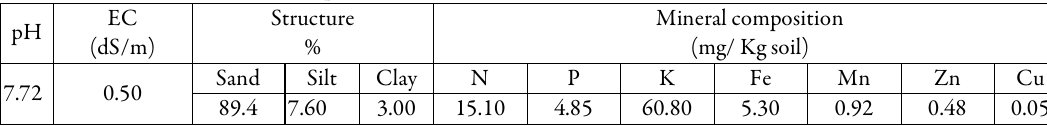
Table 1. Some chemical and physical characteristics of the soil EC pH